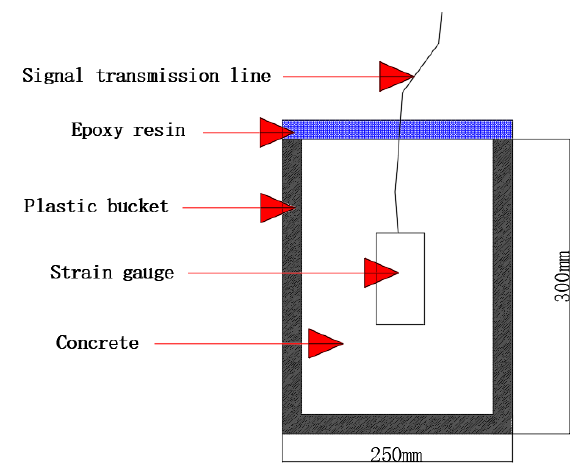
Figure 3. Schematic diagram of measuring device using strain gauge.